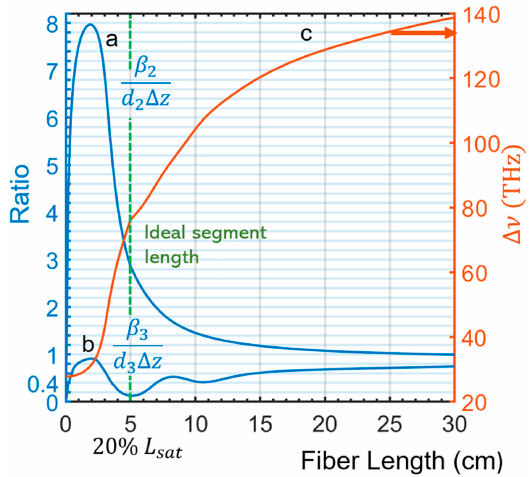
Figure 4. GNLSE simulation results. Curve a is the 1/e angular frequency bandwidth of the spectral energy density (in THz) versus propagation distance up to the normal dispersion fiber’s saturation length. Curve b is the plot of the ratio of the second-order spectral phase coefficient, β 2 , of the SCG pulse to that when there is no nonlinear effect ( d 2 ∆ z , versus propagation in the normal dispersion fiber. Curve c is the plot of the ratio of the third-order spectral phase coefficient, β 3 , of the SCG pulse to the third-order spectral phase coefficient in the absence of any nonlinear effect ( d 3 ∆ z ) versus the propagation in the normal dispersion fiber.